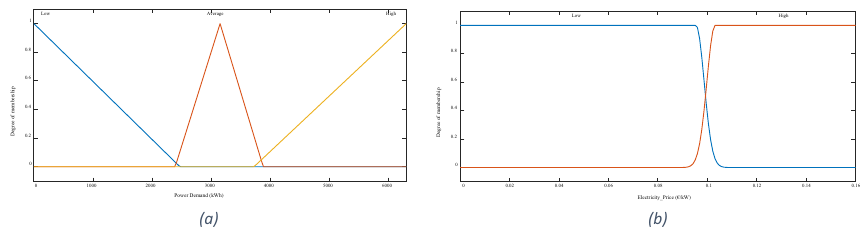
Fig. 2 a Fuzzy sets of power demand input variable, b fuzzy sets of electricity price input